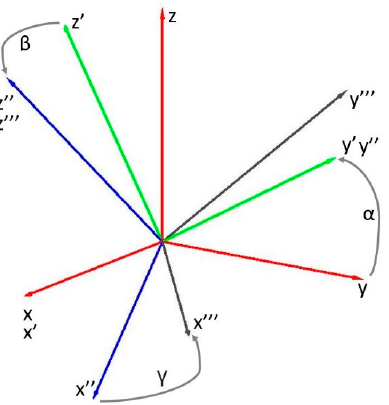
Figure 10. Complete PMSSM assembly: ( a ) Photograph and ( b ) Cross-sectional schematic.